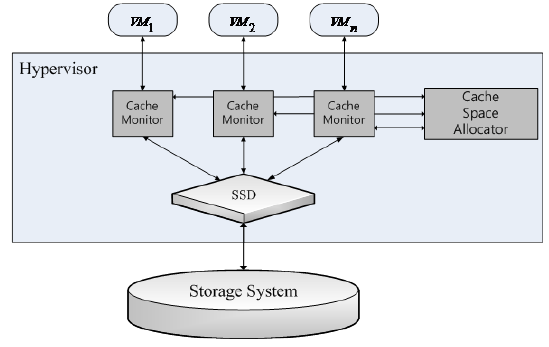
Fig. 2. The structure of the S-CAVE